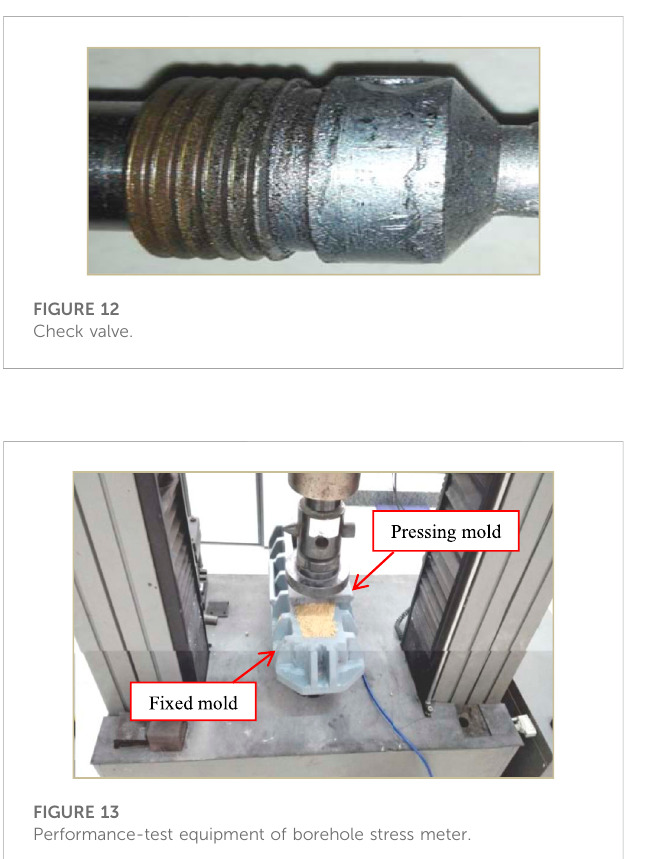
FIGURE 13 Performance-test equipment of borehole stress meter.